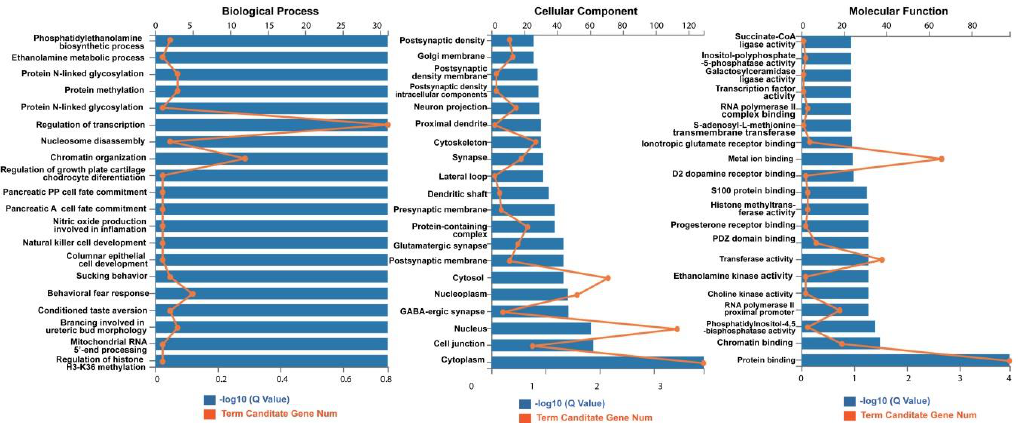
Figure 8. The gene ontology (GO) term enrichment for the predicted target genes of the 12 stably enriched DEmiRs. The result indicated that these target genes were involved in “regulation of growth plate cartilage chondrocyte differentiation” (Q = 0.1995) and “chromatin organization” (Q = 0.5012) in biological process; “cytosol” (Q = 0.01), “nucleus” (Q = 0.0003), and “cytoplasm” (Q = 0.0001) in cellular component; “metal ion binding” (Q = 0.0032), “transferase activity” (Q = 0.0316), and “protein